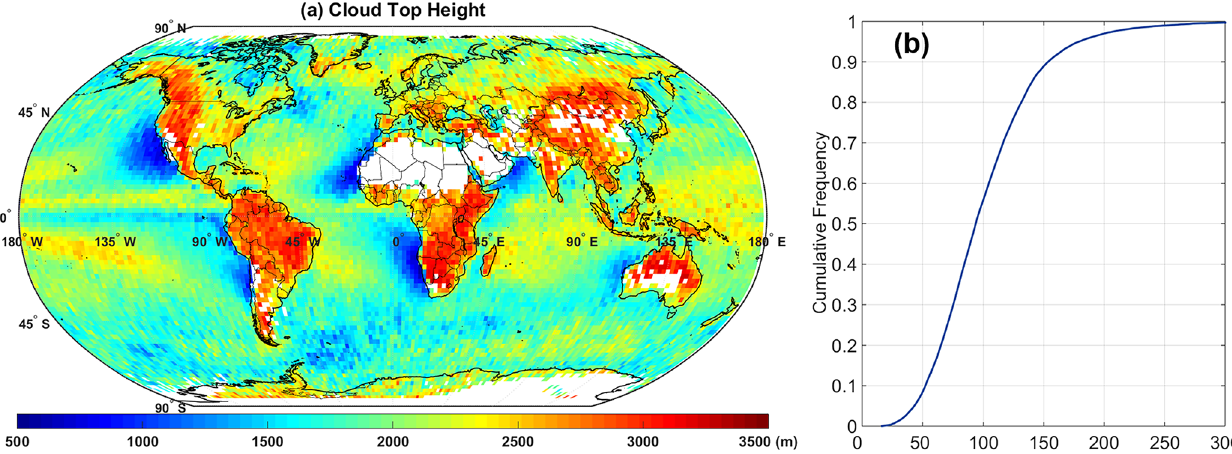
Figure A5. (a) Geographic distribution of CTH based on the maximum value of H max on a 2 ◦ × 2 ◦ latitude–longitude grid in 2014 and 2017. (b) Cumulative distribution of the difference between the CTH based on the maximum value of H max and CTH based on the mean height of the highest 10% quantile of H max in 2014 and 2017. The heights are in meters above ground level.